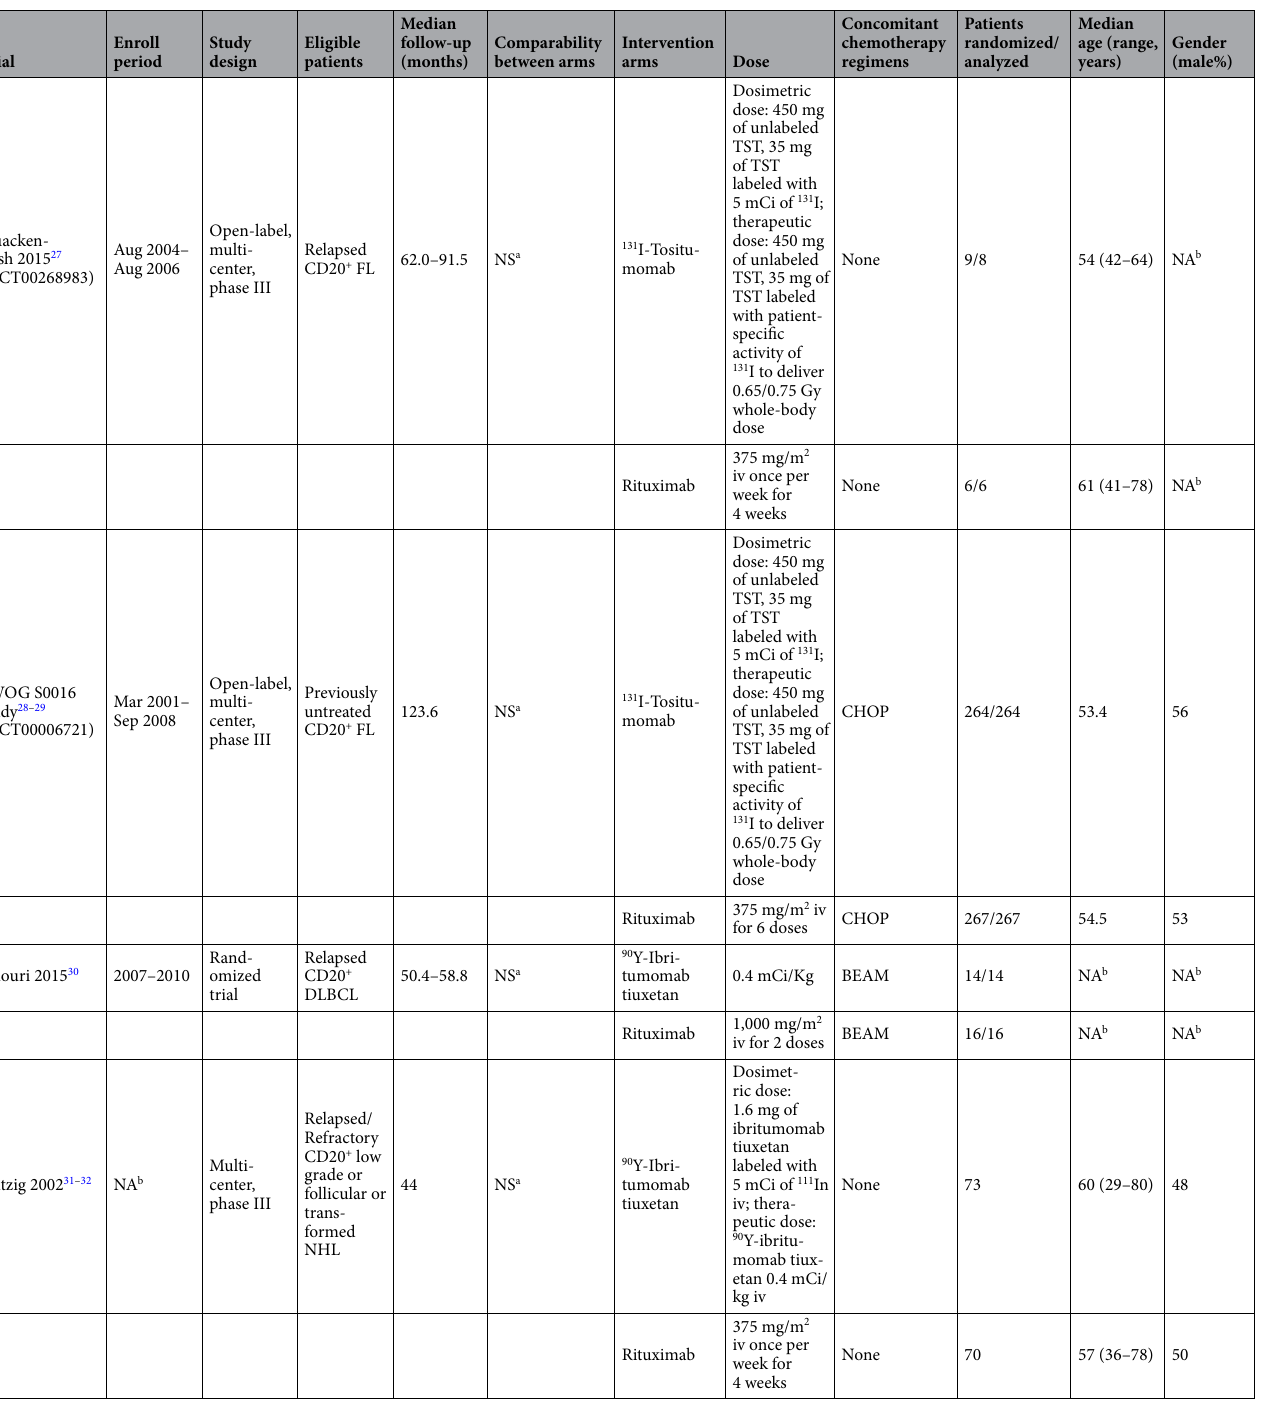
Table 1. Characteristics of the 11 RCTs included in meta-analyses. DLBCL diffuse large B-cell lymphoma, ACVBP doxorubicin, cyclophosphamide, vindesine, bleomycin, and prednisone, CHOP cyclophosphamide, doxorubicin, vincristine, and prednisone, FL follicular lymphoma, CVP cyclophosphamide, vincristine, and prednisone, NHL non-Hodgkin lymphoma, MZL marginal zone lymphoma, LPL lymphoplasmacytic lymphoma, SLL small lymphocytic lymphoma, DHAP cisplatin, cytarabine, dexamethasone, BEAM carmustine, etoposide, cytarabine, and melphalan, 131 I iodine-131, TST Tositumomab, 90 Y yttrium-90, 111 In indium-111. a No significant differences. b Not